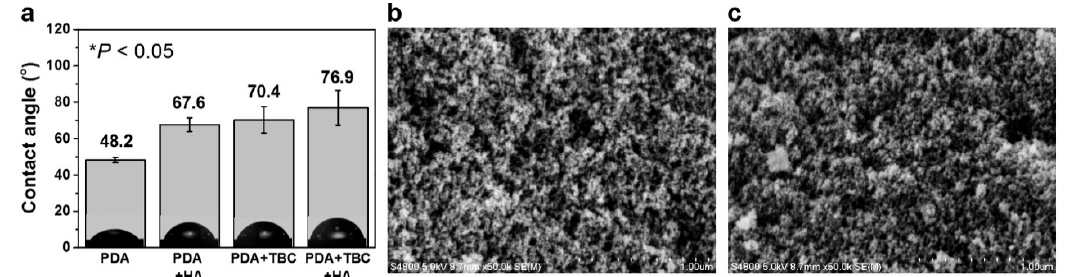
Figure 4. ( a ) Water contact angles on catechol-coated SiO 2 wafers incubated for 12 h with PDA, PDA + HA, PDA + TBC, and PDA + TBC + HA. ( p < 0.05, one-way ANOVA) SEM images of ( b ) PDA + TBC and ( c ) PDA + TBC + HA-modified aerogel.